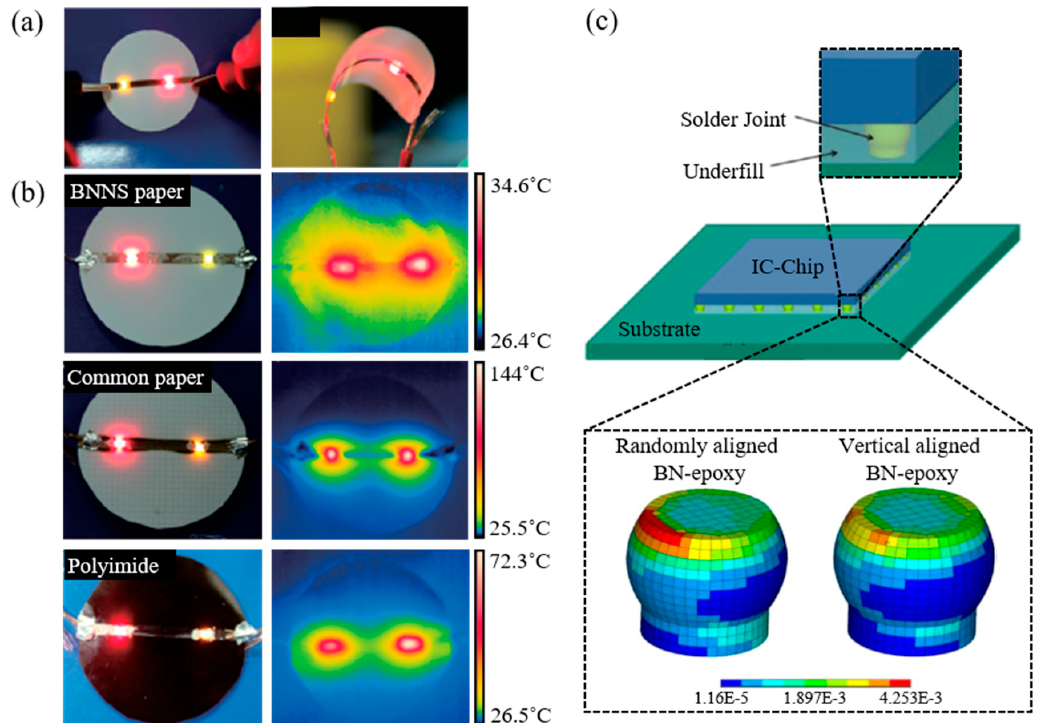
Figure 5. Practical examples of enhanced heat dissipation and minimized thermal shrinkage with aligned ceramic/polymer composites. ( a , b ) Heat dissipation results of LEDs on BN-PVA composite paper (upper), common paper (middle), and polyimide (bottom), depending on the substrate [57]. Reprinted with permission from [57] Copyright (2015) Royal Society of Chemistry. ( c ) Schematic illustration of an integrated IC chip with underfill using a BN-epoxy composite for encapsulation (upper). The simulation of an accumulated plastic strain to solder joints influenced by the underfill’s CTE of randomly dispersed and vertically aligned BN-epoxy composites (bottom) [52]. Reprinted with permission from [52] Copyright (2013) American Chemical Society.